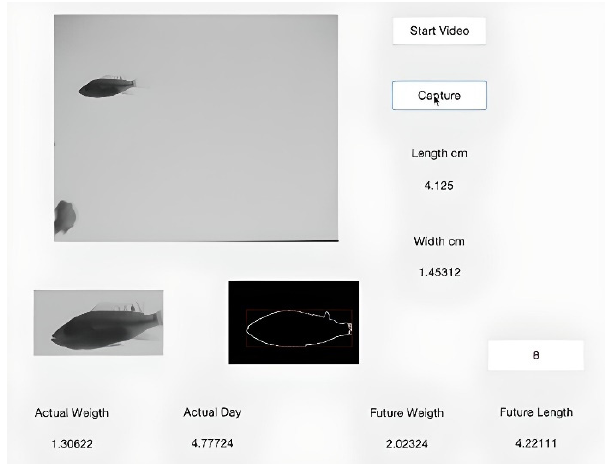
Figure 9. User interface.